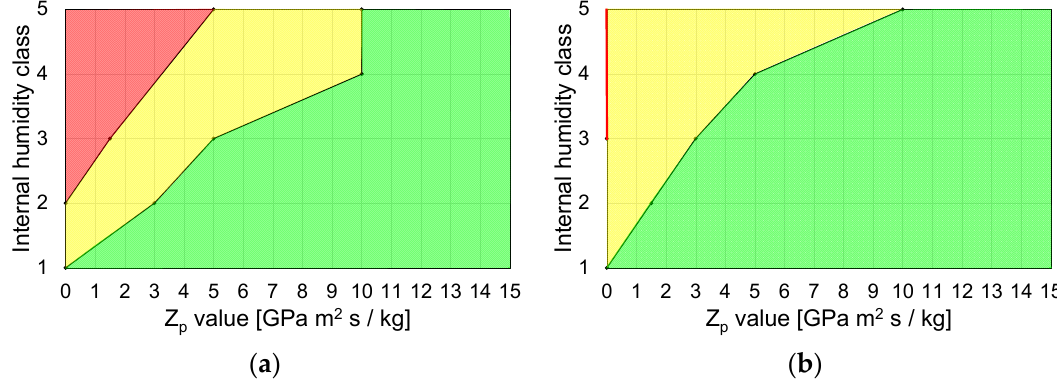
Figure 6. Risk of mould growth on the wind barrier towards the thermal insulation for Lund climate. The wood-frame wall contains thermal insulation of ( a ) mineral wool and ( b ) cellulose. In the green area, there is no risk for mould growth (MI ≤ 2), whereas the red area indicates a risk for mould growth (MI > 3). The yellow area is where further investigations must be conducted (2 < MI ≤ 3). Z p -values represent only the value for the vapour barrier.